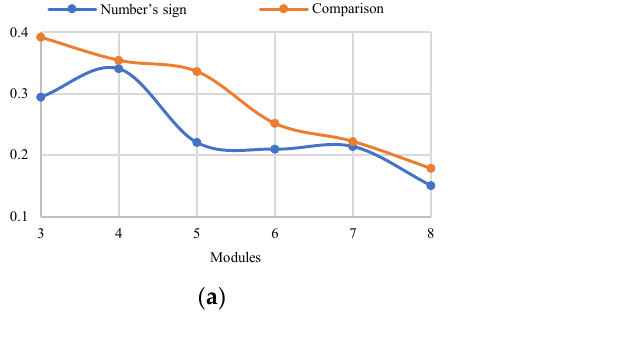
Figure 2. Comparison of DSN-EN and AM methods for determination of the number’s sign and comparison with ( a ) a dynamic number of modules (cid:1868) and ( b ) a dynamic bit width.